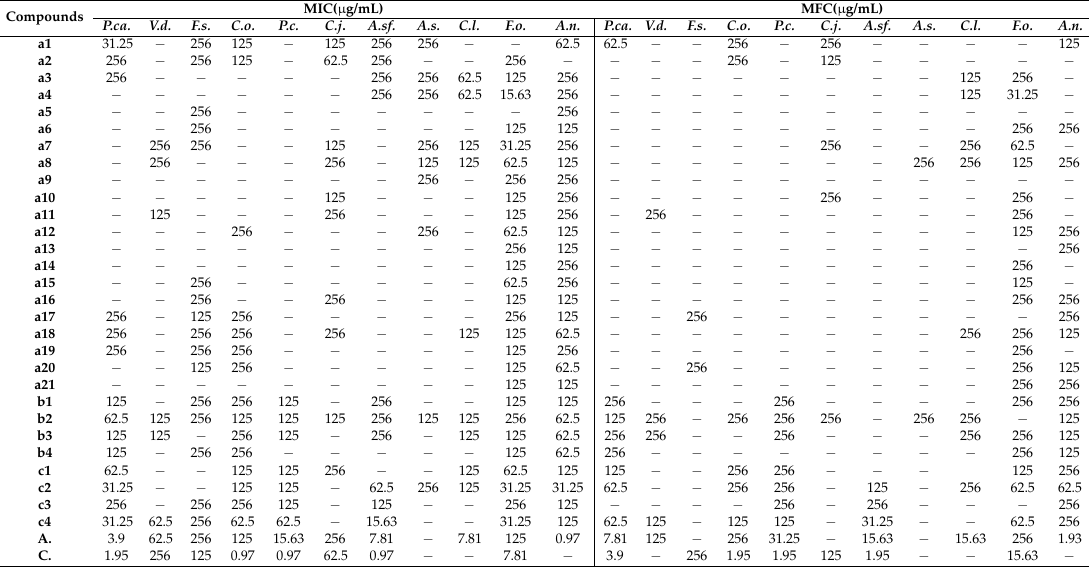
Table 3. Inhibitory effect of synthesized compounds against a wide variety of plant pathogen